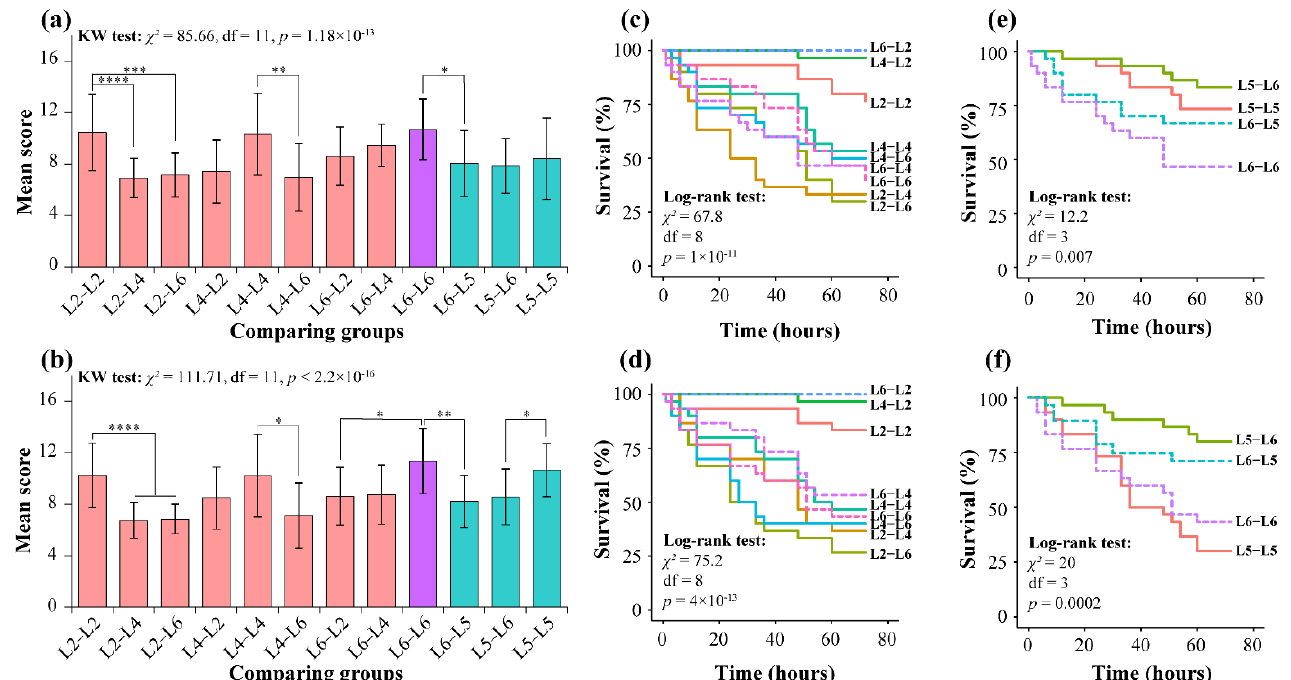
Figure 1. Statistical analysis of aggressive behavior and Kaplan–Meier analysis for different assays. Mean aggression behavior scale (ABS) of different comparing groups with food ( a ) or without food ( b ). Salmon, turquoise, and violet bars represent conspecific groups, heterospecific groups, and the group share in conspecifics and heterospecifics, respectively. The Kruskal–Wallis H test was used for overall group comparisons, followed by the Nemenyi test for two-group pairwise comparisons: ns, p > 0.05; *, p < 0.05; **, p < 0.01; ***, p < 0.001; ****, p < 0.0001. The survival rate for conspecifics of T. xiaojinensis when providing food ( c ) or without food ( d ). The survival rate for H. armigera and T. xiaojinensis caged with conspecifics or heterospecifics when providing food ( e ) or without food ( f ). The “death event” was marked when one of the events was death. The log-rank test was performed to yield significance for overall groups. L2, L4, and L6 represent 2nd, 4th, and 6th instar T. xiaojinensis larvae, respectively; L5 denotes 5th instar H. armigera . The observed object in the group is shown before the hyphen. For example, the L2–L4 group, the combination of L2 vs. L4 focuses on L2; the L4–L2 group, the combination of L2 vs. L4 focuses on L4.